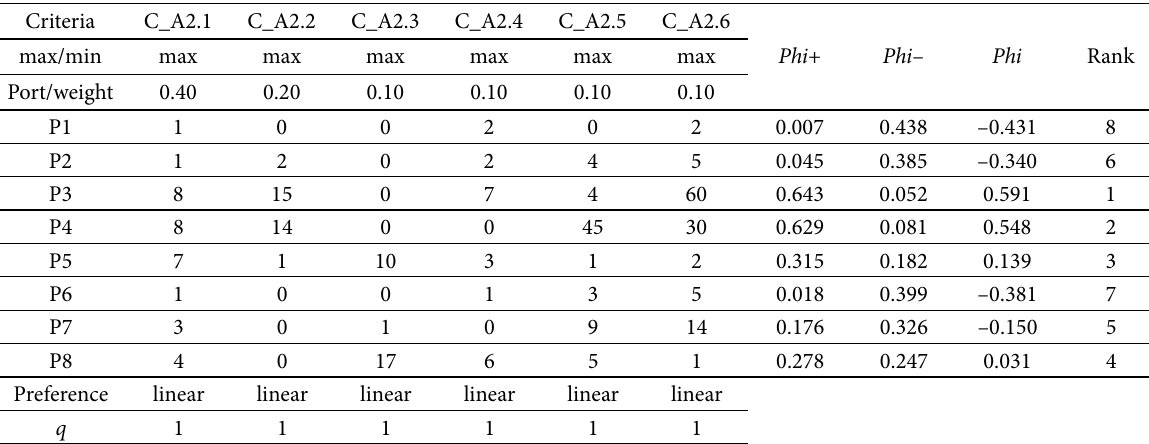
Table 4. PROMETHE II complete rank of the ports for A2 sub-criteria